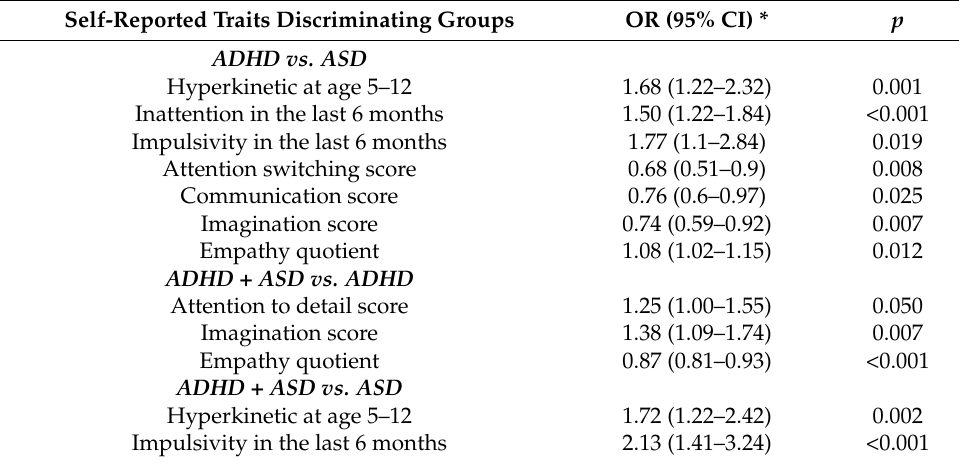
Table 4. Results from the stepwise logistic regression analysis for the discrimination of ADHD, ASD, and ADHD/ASD groups of patients from the self-reported number of ADHD and ASD